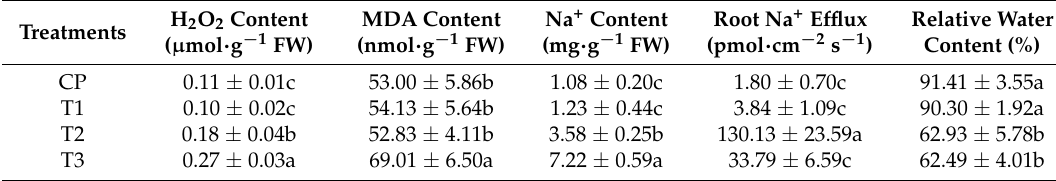
Table 1. H 2 O 2 , malondialdehyde (MDA), Na + and relative water contents in the leaf and average root Na + flux in Jerusalem artichoke after four days of salt stress. Data in the table indicate the mean of five replicates ( ± SD). Within each column, means followed by the same letters are not significantly different at p < 0.05. FW indicates fresh weight. CP indicates control plants without pretreatment and NaCl stress; T1 indicates tungstate-pretreated plants without NaCl stress; T2 indicates non-pretreated plants under 150 mM NaCl stress; T3 indicates tungstate-pretreated plants under 150 mM NaCl stress.